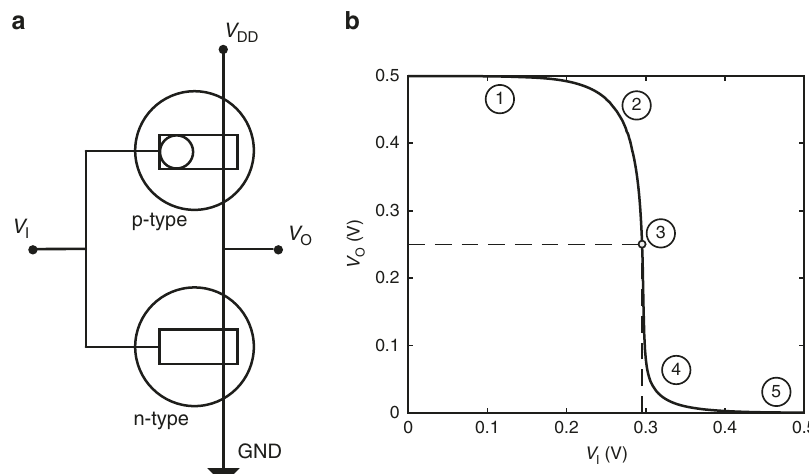
Fig. 1 Organic electrochemical transistor complementary ampli fi er. a Organic electrochemical transistor complementary ampli fi er architecture. The input voltage ( V I ) is connected to the gates of the transistors, and the output voltage ( V O ) is collected at their drains. The supply voltage ( V DD ) is connected to the source of the p-type OECT, and the source of the n-type is grounded (GND, V GND = 0 V). b Typical transfer characteristic of an OECT complementary ampli fi er. The gray dot identi fi es V M (viz. the required V I to have V O = V DD /2) and the various regions of operation are highlighted with numbers.